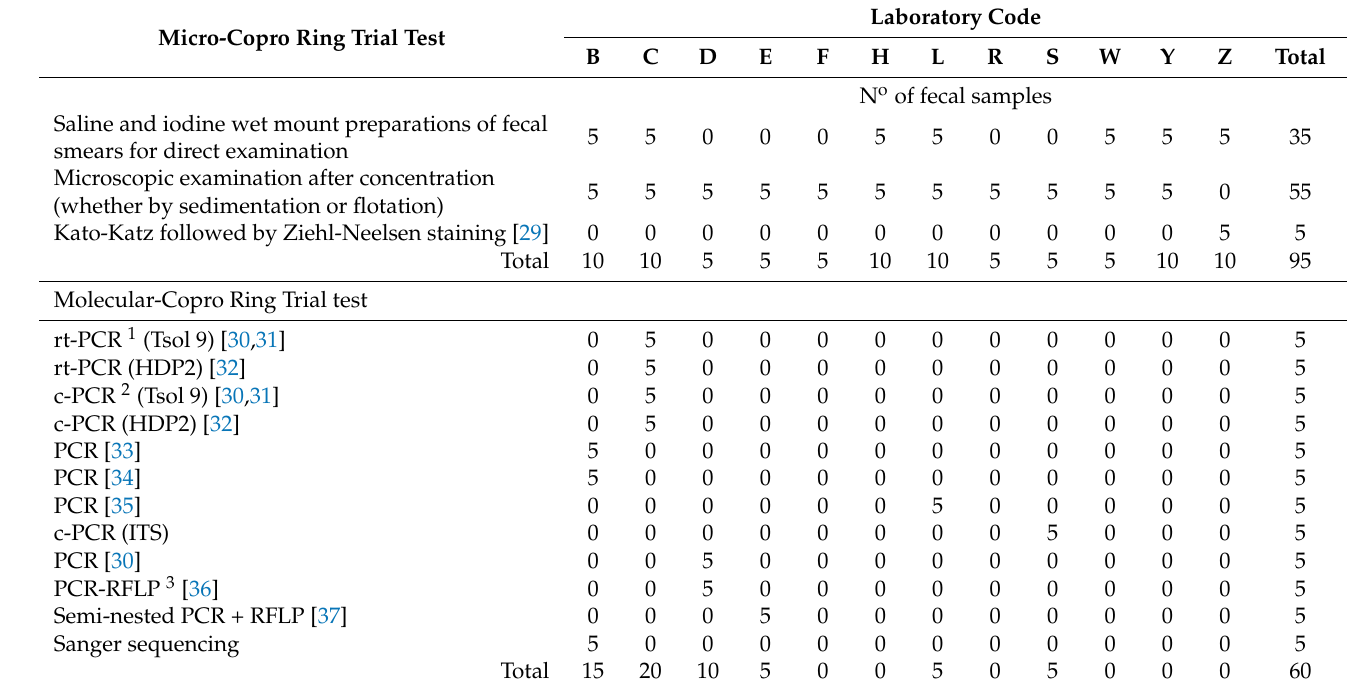
Table 10. Number of fecal samples tested by each laboratory per assay.